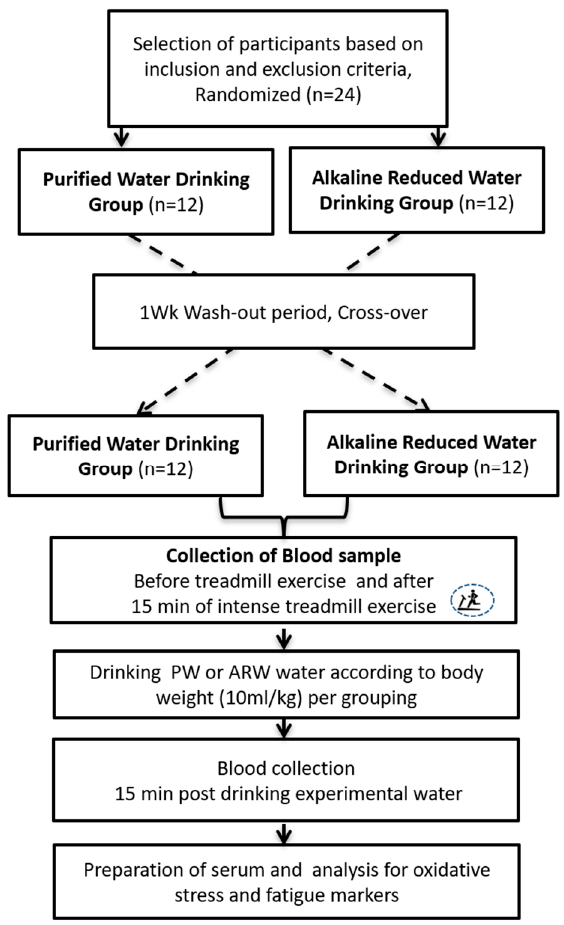
Figure 1. Experimental design of the cross-over study.